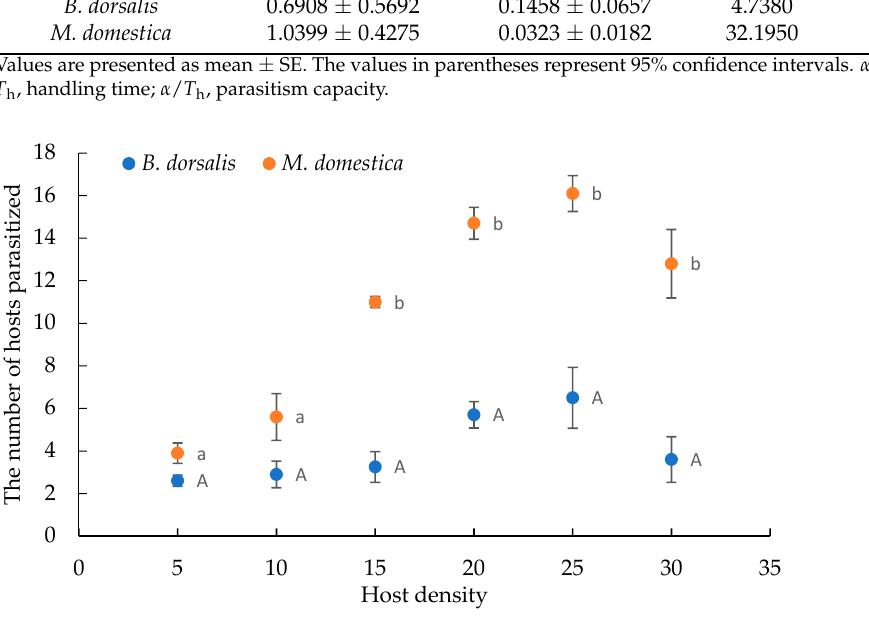
Figure 1. Numbers of B. dorsalis and M. domestica pupae parasitized by S. endius in relation to host density. Different small or capital letters are significantly different ( p < 0.05, t -test).